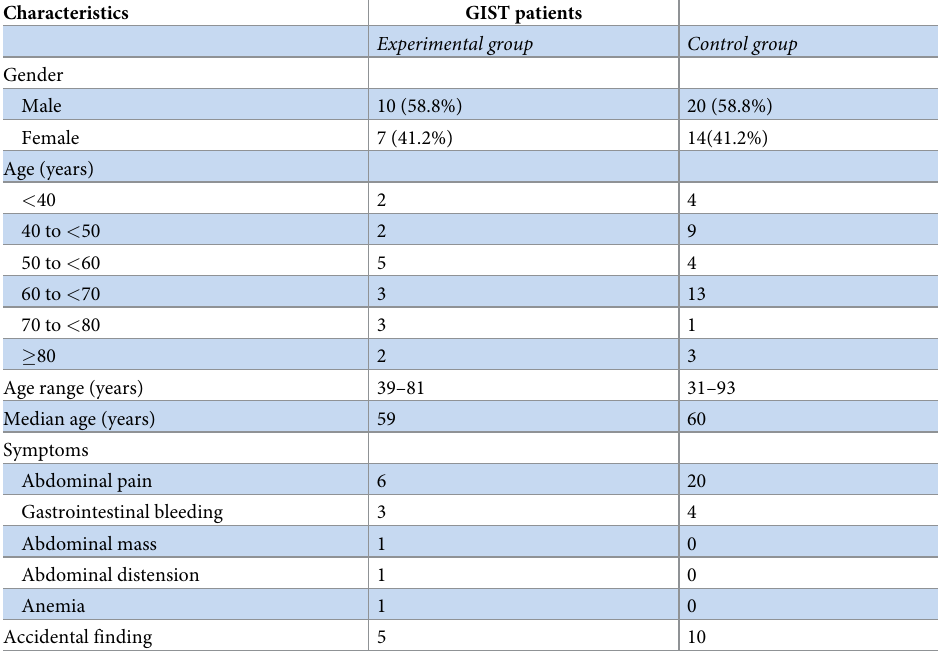
Table 1. Demographic and clinical characteristics of GIST patients in the experimental group and control group.